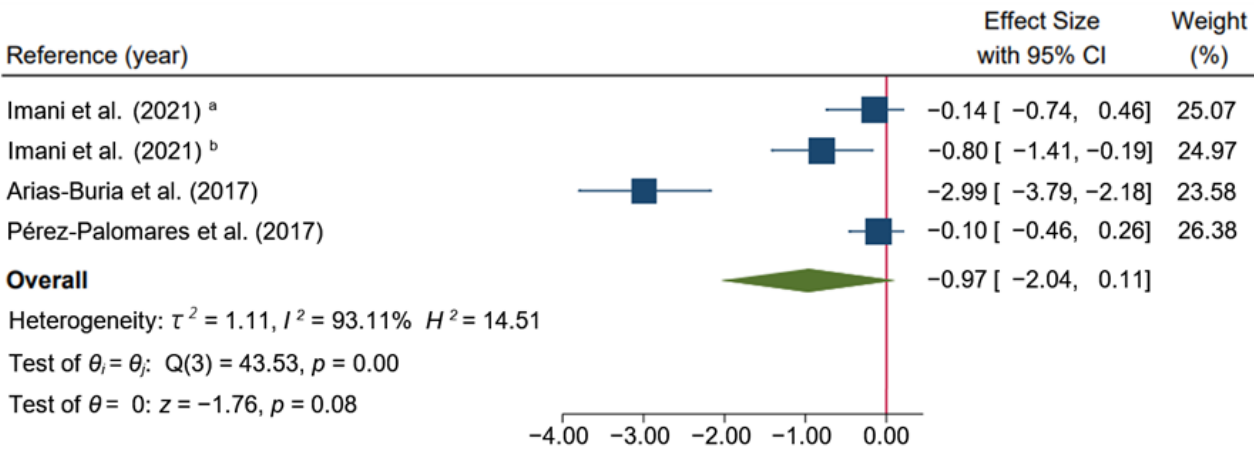
Figure 6. Forest plot of comparison in the short-term: Dry Needling group alone or combined with exercise therapy versus other types of intervention (exercise, or a combination of exercise, massage, passive mobilization plus hot packs and analgesic electrotherapy), outcome: Disability. a : Hong dry needling technique (fast-in fast-out intervention); b : Deep dry needling (static needling) [32,34,35]. However, no significant differences between groups were found on disability at the mid-term. The meta-analysis suggest that dry needling had a large effect (SMD: −0 .85; 95% CI: −1 .74 to 0.04; I 2 = 89.44%; p = 0.06; very-low quality evidence) (Figure 7).